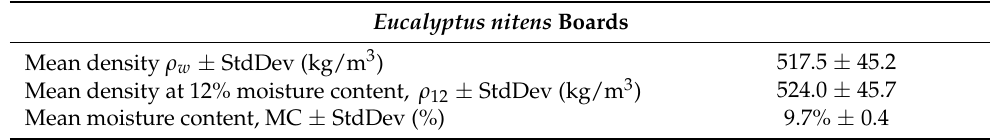
Table 1. Test results of the average moisture content and density for E. nitens